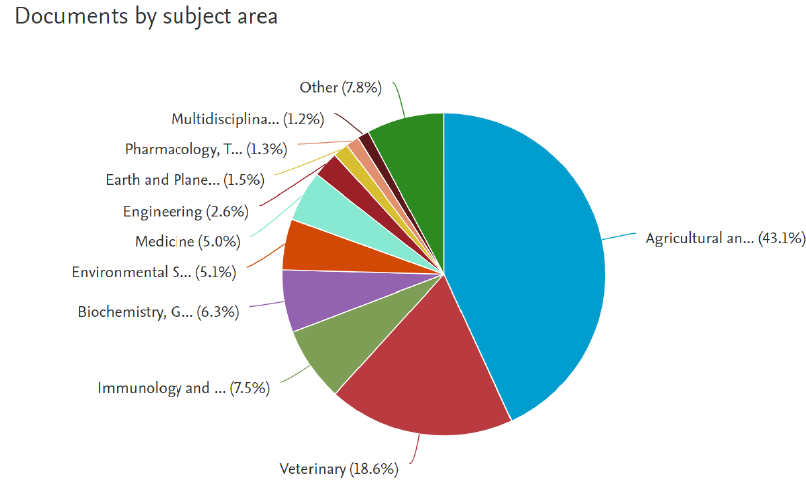
Figure 2. The relative number of articles per subject, SCOPUS cited on